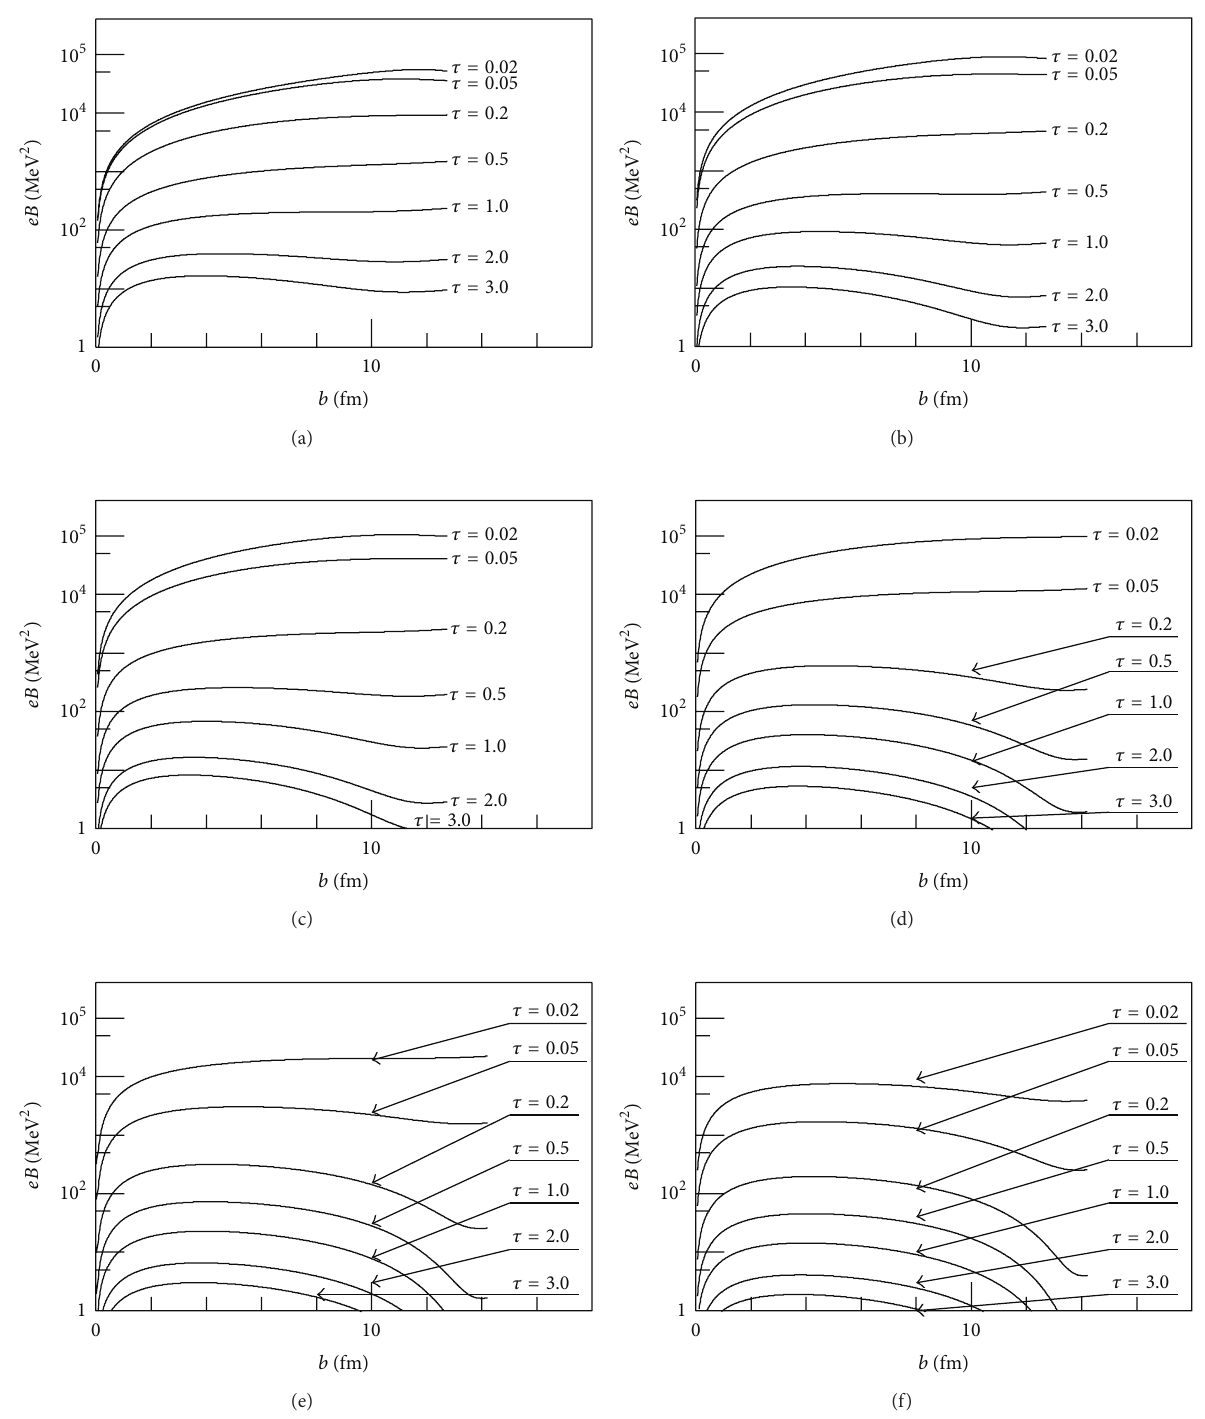
Figure 1: The dependencies of magnetic fields on impact parameters at different proper times 𝜏 at different energies of central mass system of √𝑠 𝑁𝑁 = 62.4 GeV (a), 130GeV (b), 200 GeV (c), 900 GeV (d), 2760 GeV (e), and 7000 GeV (f),